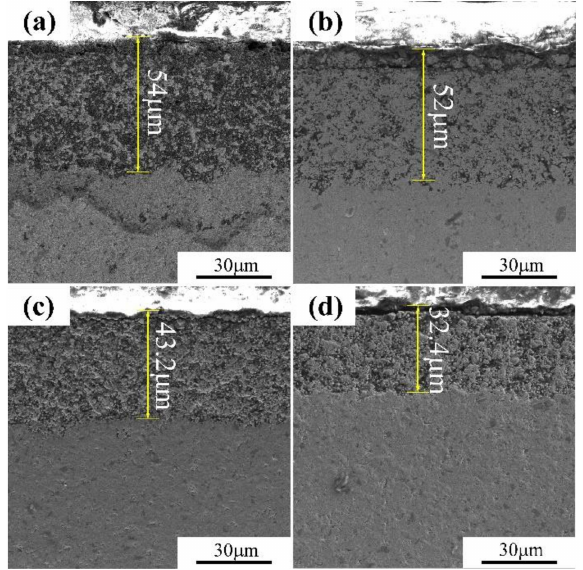
Figure 13. SEM images of the corrosion cross-sectional area of the (Ti,W)C-xTa-based cermets immersed in 0.5 mol/L HNO 3 solution for 120 h, x in wt.%: ( a ) x = 0, ( b ) x = 1, ( c ) x = 3, and ( d ) x =